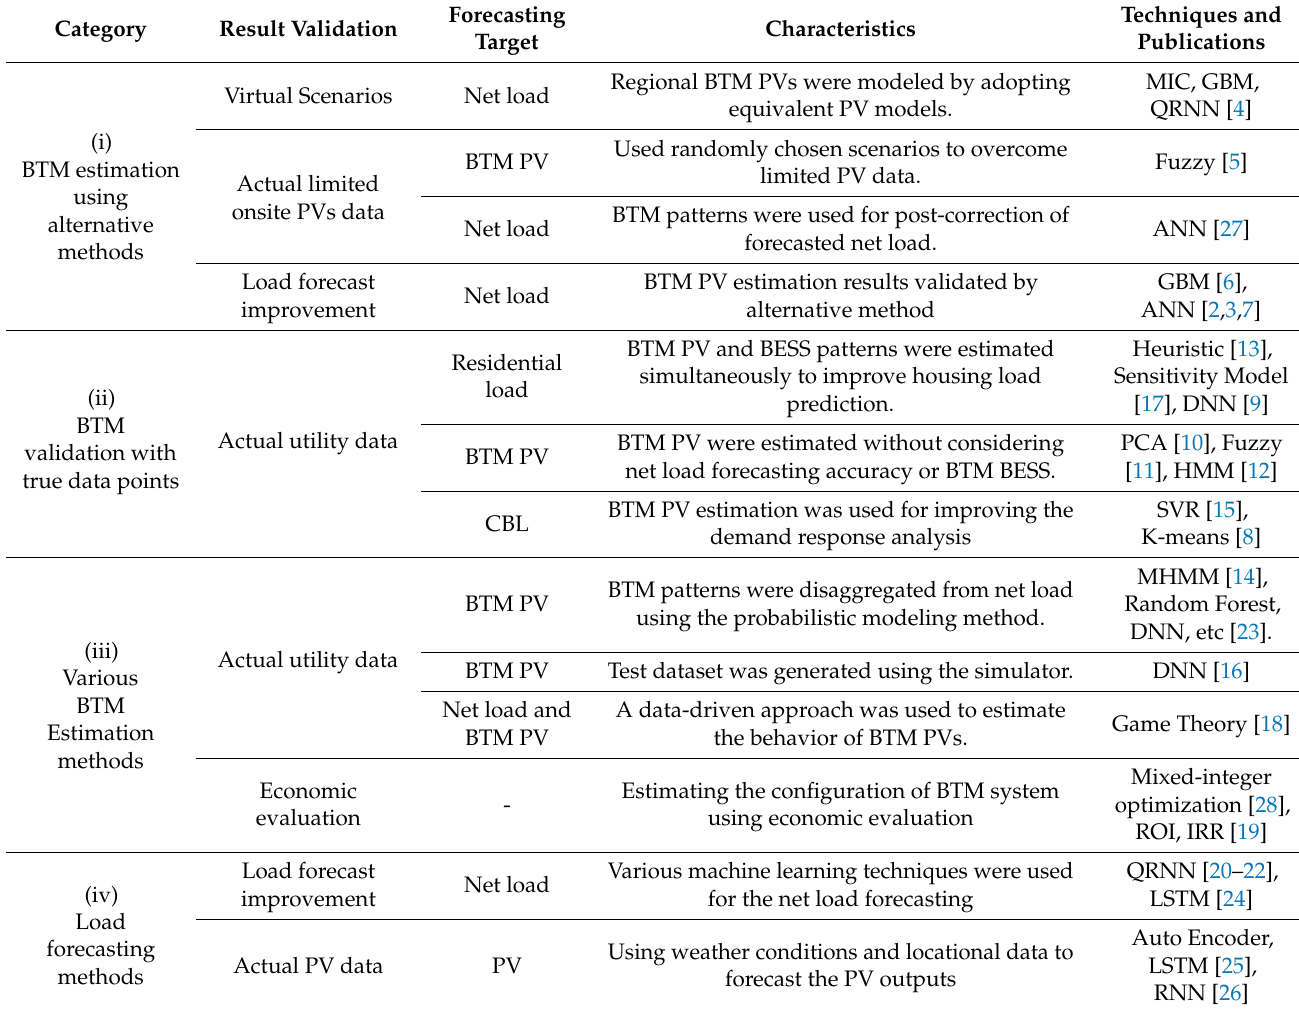
Table 1. Summary of previous studies for BTM estimation and net load